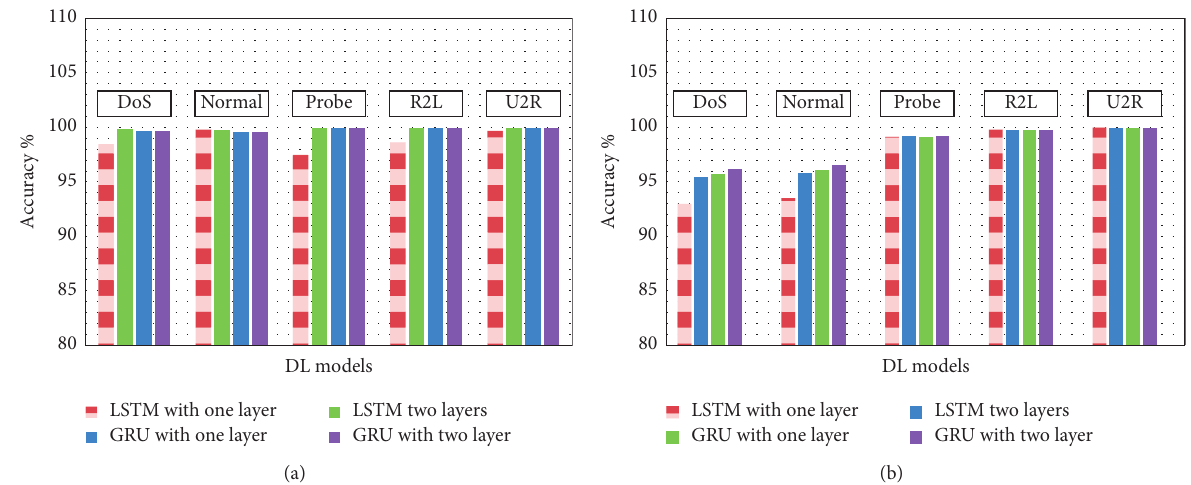
Figure 9: The results of deep learning cross-validation performance for the KDD dataset: (a) accuracy using all features and (b) accuracy using selected features.